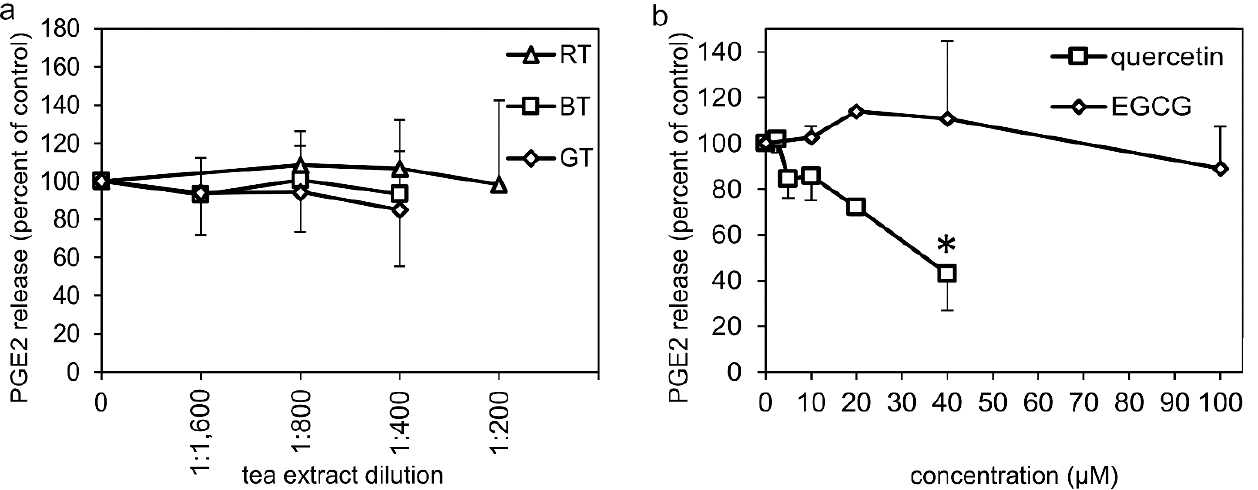
Figure 3. Cellular assay for the combined enzymatic activity of cPLA2, COX and PGE synthases to produce PGE2 in LPS-pretreated (24 h) monocytes during a 1 h treatment with ( a ) tea extracts; ( b ) EGCG or quercetin. PGE2 formation was initiated by stimulation with 4 µM A23187 during the last 45 min of the 1 h treatment with tea extracts or polyphenols. Results for each data point represent the mean value ± SD of 2–7 independent experiments from different monocyte preparations, and are expressed as percent of PGE2 released from the LPS + A23187-treated controls. * denotes a significant inhibition ( p < 0.05). BT: black tea extract, GT: green tea extract, RT: Rooibos tea extract, EGCG: epigallocatechin gallate.